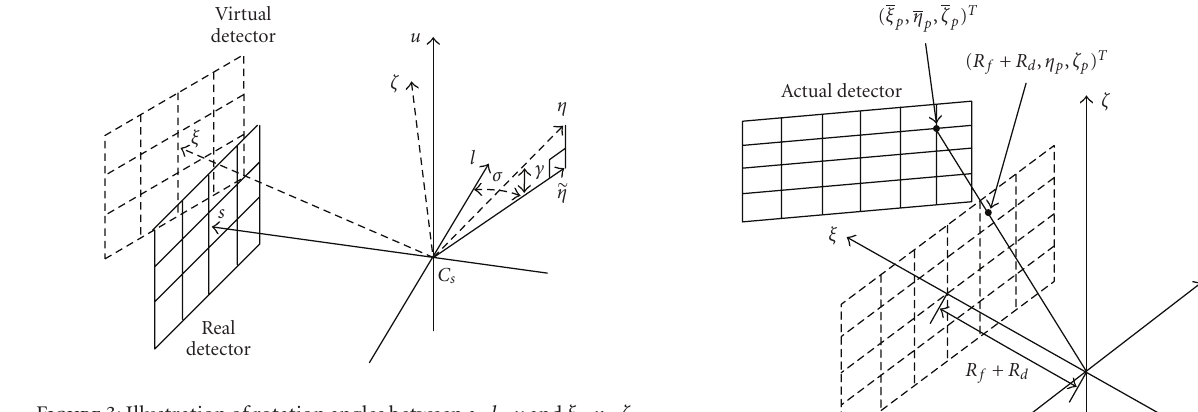
Figure 3: Illustration of rotation angles between s − l − u and ξ − η − ζ .